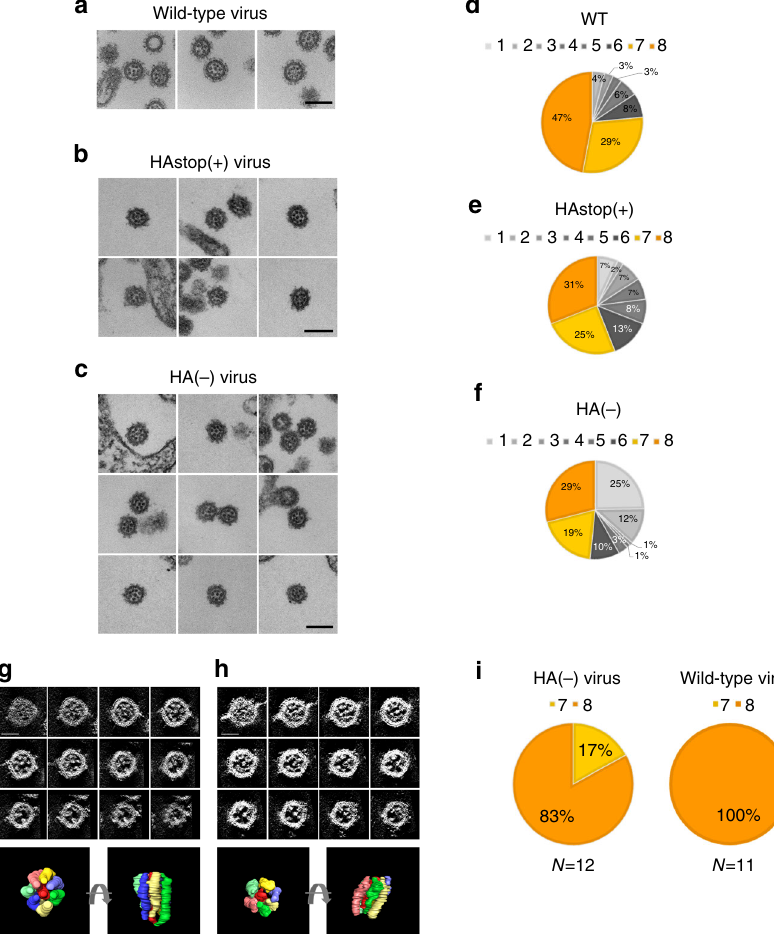
Fig. 2 Electron micrographs of the HA( − ), HAstop(+), and wild-type viruses. HA-MDCK cells were infected with the wild-type virus, HAstop(+) virus, or HA( − ) virus, and ultrathin sections of budding virions were observed by EM. a Wild-type, b HAstop(+), and c HA( − ) virions, which contain eight RNPs in the speci fi c “ 1+7 ” con fi guration, bud from HA-MDCK cells. Bars, 100 nm. d – f Proportion of wild-type, HAstop(+), and HA( − ) virions containing 8, 7, 6, 5, 4, 3, 2, and 1 RNPs. Approximately 100 virions embedded in 100-nm-thick ultrathin sections were counted for each virus. g , h . Digital sections of a whole HA ( − ) virion containing eight RNPs ( g ) and a whole HA( − ) virion containing seven RNPs ( h ) from the top (upper left panel) to the bottom (lower right panel), computationally generated by electron tomography (ET). Three-dimensional models of the RNPs within the virions from the top (left) and side (right) views are shown below the digital sections panel. Bars, 50 nm. i The proportion of whole virions containing different numbers of RNPs. Approximately 10 virions each were 3D-reconstructed by ET, and the number of RNPs within each whole virion was